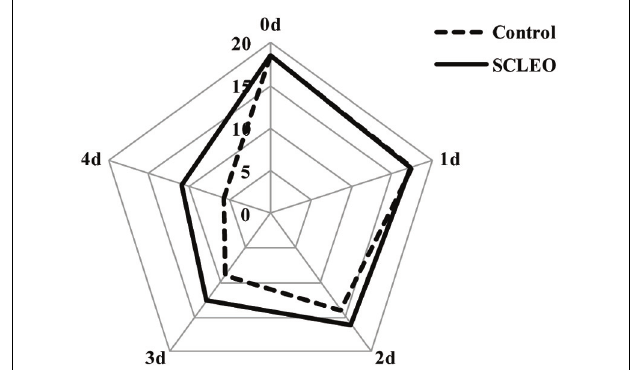
FIGURE 4 | Effects of SCLEO vapor treatment on the sensory acceptance of fresh strawberries.